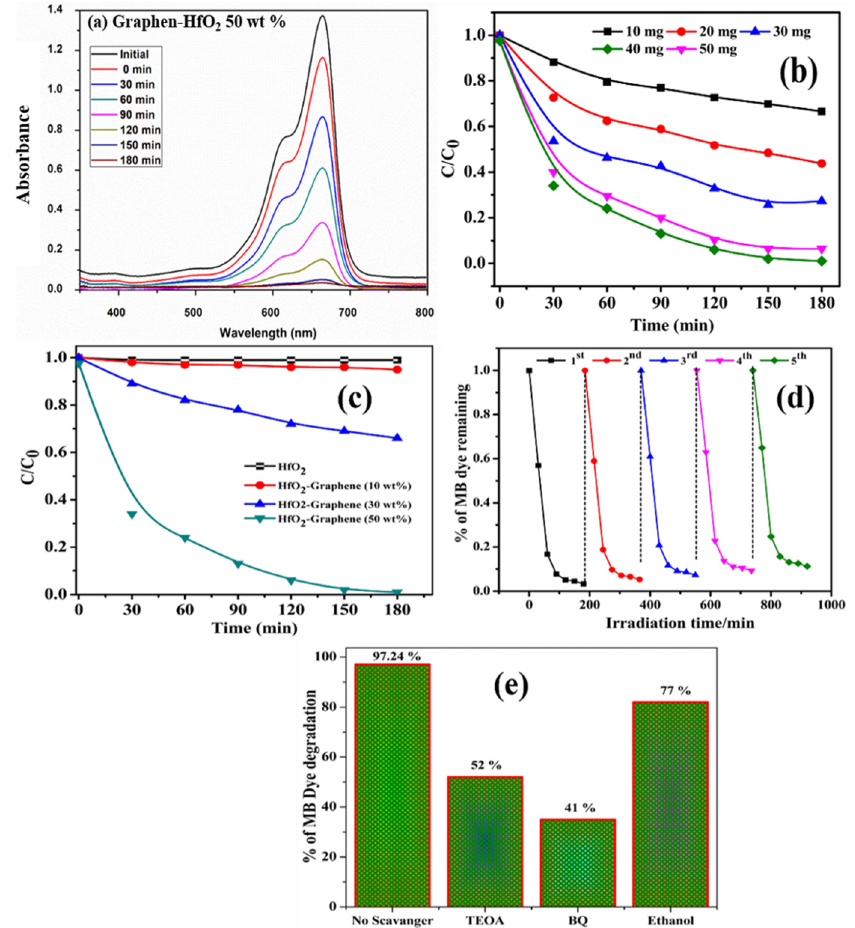
Figure 7. UV-vis absorption spectra of MB solution during the photodegradation under UV light. ( a ) HfO 2 -graphene (50 wt%) nanocomposites, ( b ) different dosages of catalysts, ( c ) c/c 0 vs. time, ( d ) number of recycling tests, and ( e ) scavenger test photodegradation of MB solution by all the cata- lysts.